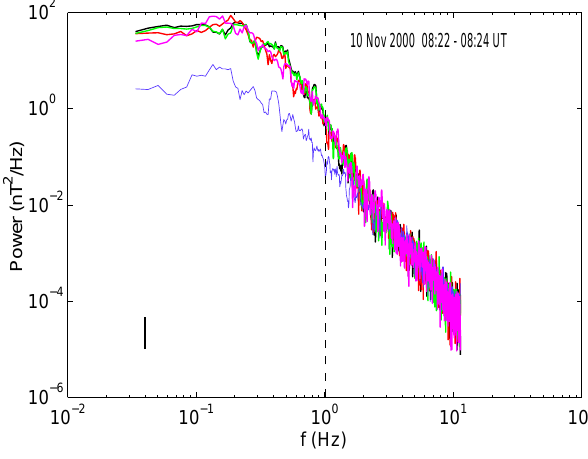
Fig. 4. Power spectra of the maximum variance magnetic field com- ponent measured by all four spacecraft between 08:22 and 08:24 UT of 10 November 2000 (day 315). The blue line shows the power spectrum of the intermediate variance component observed by Clus- ter 3. The vertical dashed line shows the proton gyro-frequency es- timated using the background magnetic field magnitude of ∼